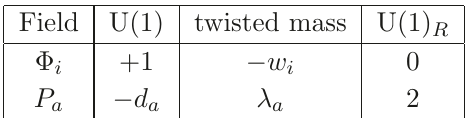
Table 1 . Matter content of the U(1) GLSM for the complete intersection variety X 1 in P n − 1 . Here i = 0 , . . . , n 1 and a = 1 , . . . , r −